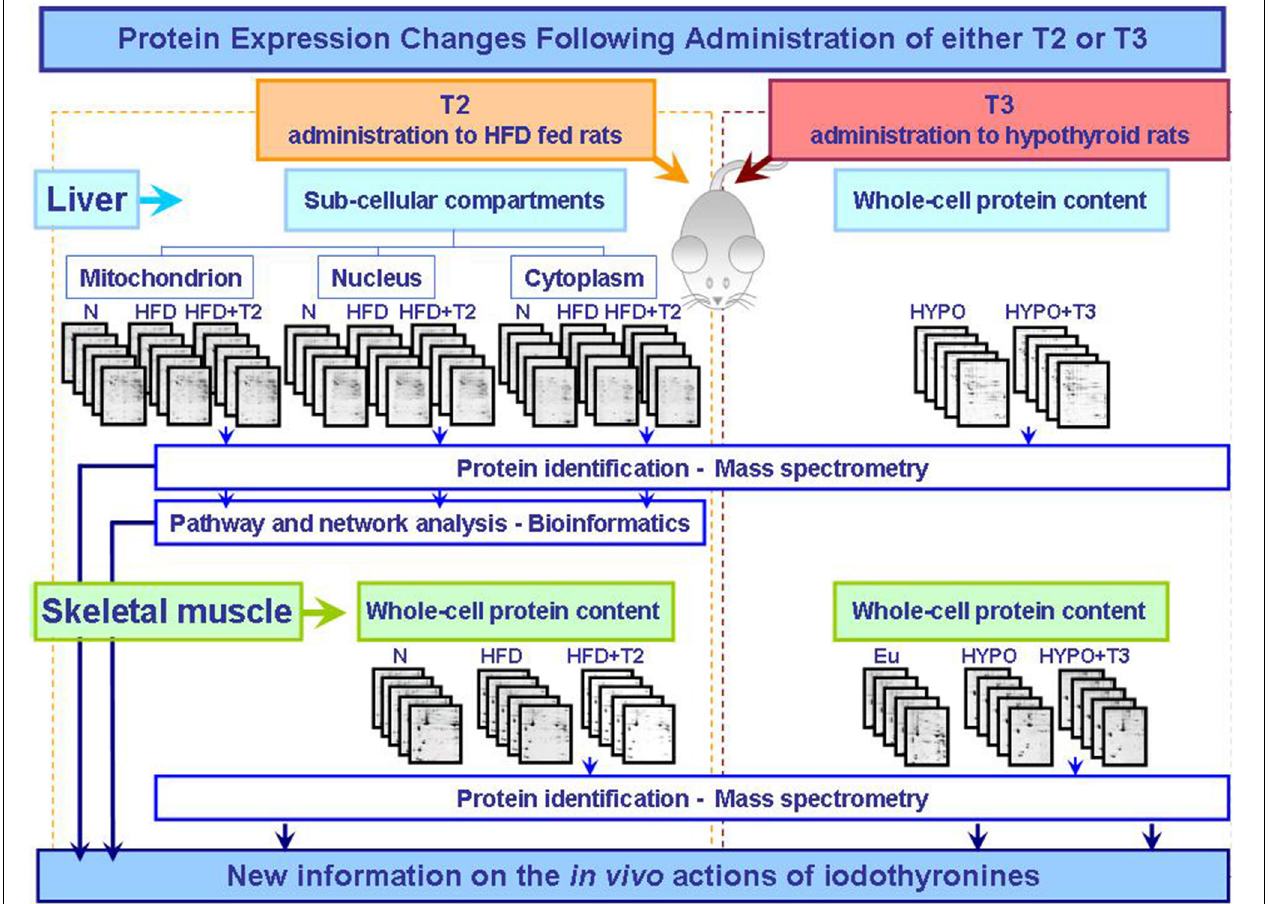
FIGURE 1 | Synoptic of the workflow of the proteomic approaches so far utilized to obtain new information on the actions that T2 and T3 exert in vivo in key metabolically active tissues central in the control of energy balance. The described studies were performed as integrated approaches including 2D-E, mass